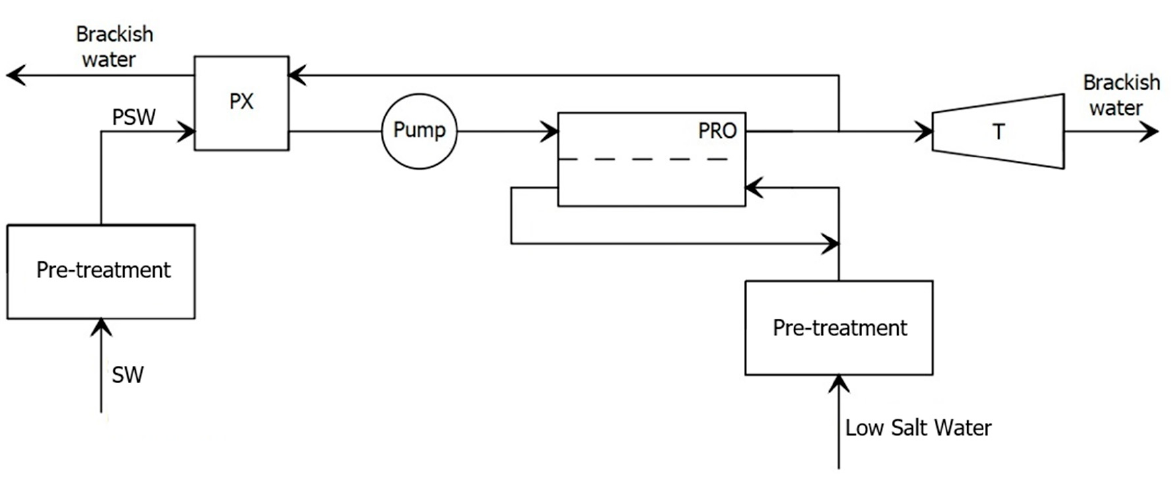
Figure 6. Schematic diagram of typical PRO process for the production of renewable osmotic energy.